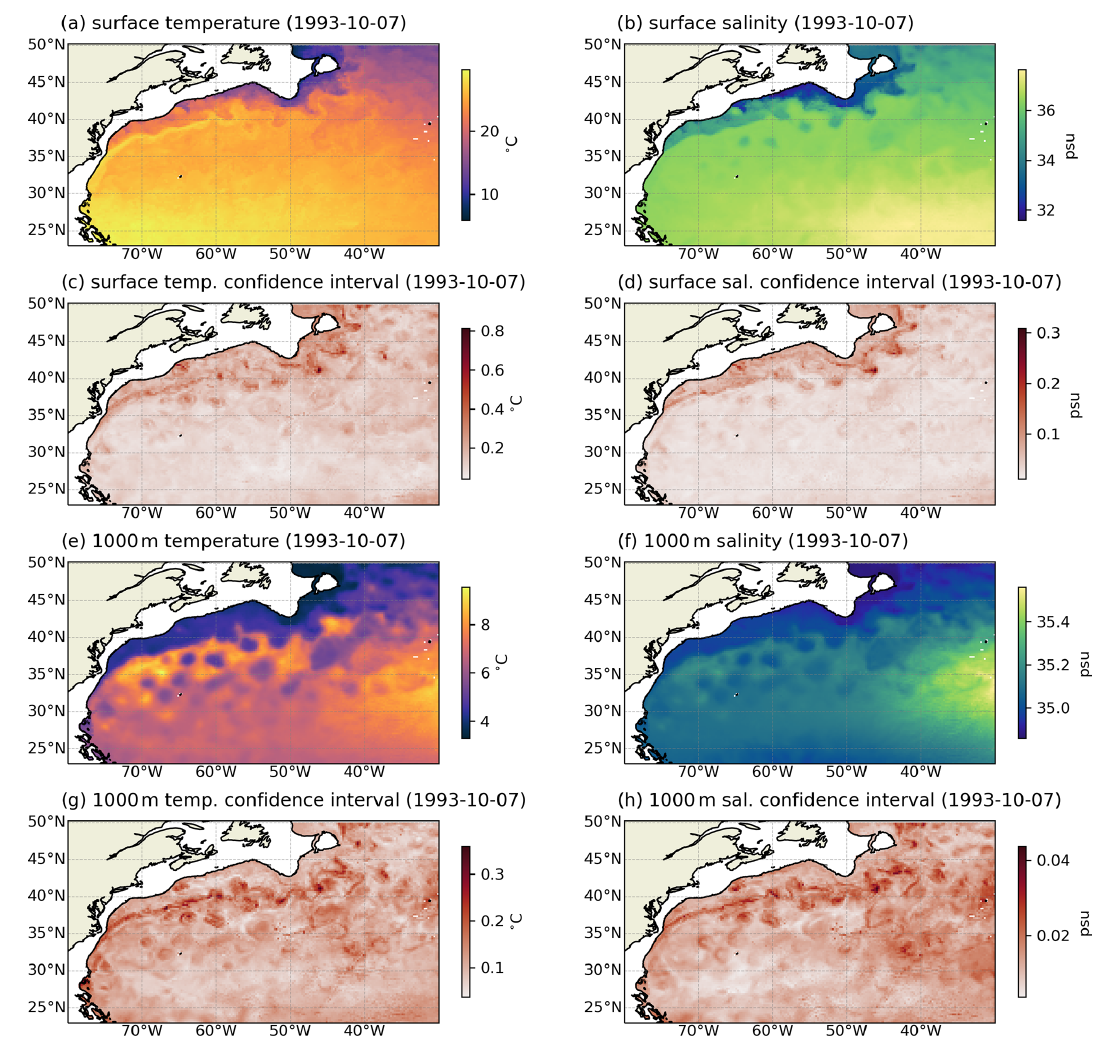
Figure 6. OSnet temperature and salinity maps for 7 January 1993, at the surface (a, b) and at 1000m (e, f) . Their respective confidence intervals are displayed too, i.e., the standard deviation of the 15 bootstrapped models (c, d, g, h)